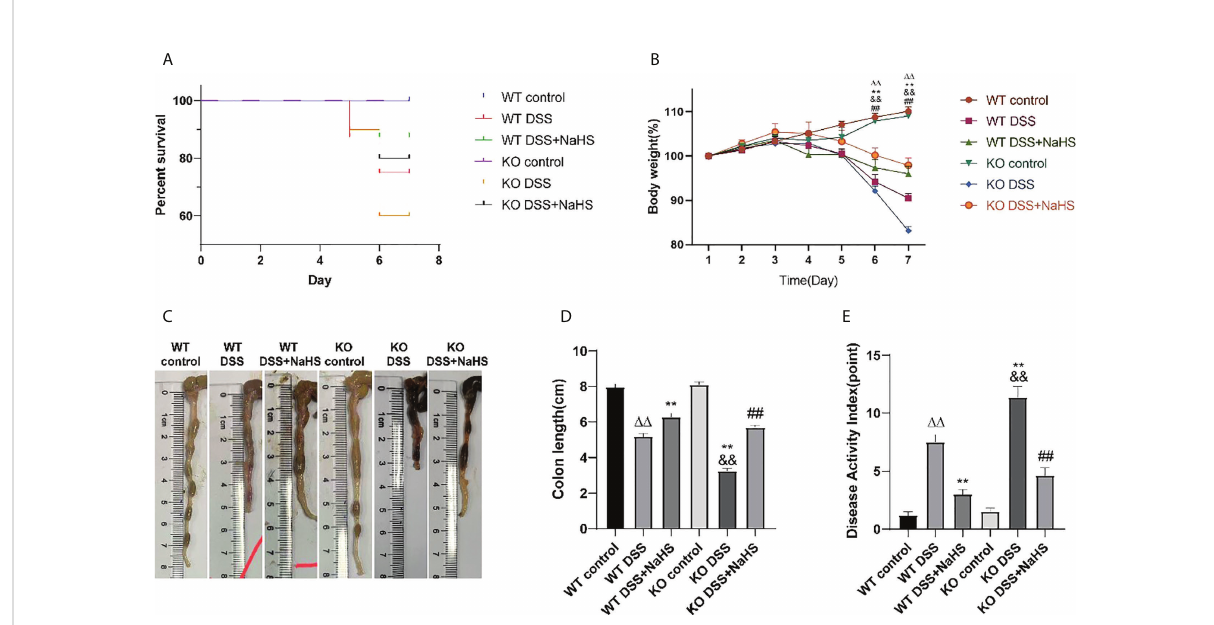
FIGURE 1 Effect of cystathionine- g -lyase (CSE)-derived hydrogen sul fi de (H2S) on dextran sodium sulfate (DSS)-induced ulcerative colitis in mice. (A) Percent survival. (B) Body weight (shown as the percentage of initial body weight). (C) Typical pictures of colon. (D) Colon length. (E) Disease activity index (DAI) score. All data are expressed as the mean ± SEM, N=6. DD P 0.01 vs wild-type(WT) control group; **P < 0.01 vs WT DSS group; && P < 0.01 vs knockout (KO) control group; ## P < 0.01 vs KO DSS group .